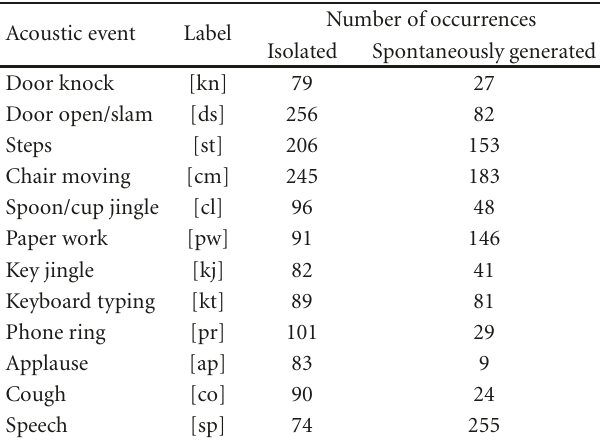
Table 1: Number of occurrences per acoustic event class for train and test